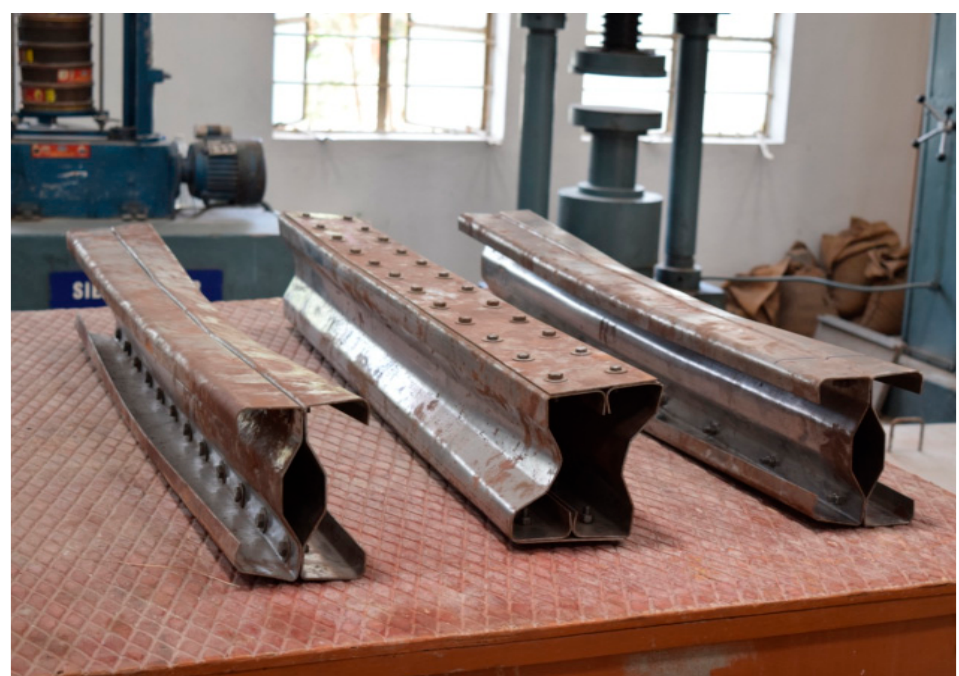
Figure 12. Tested specimens.